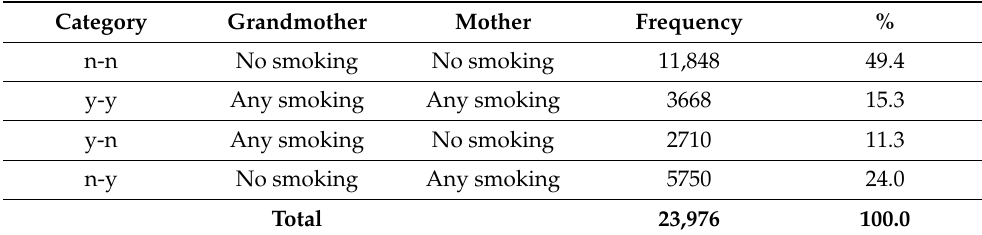
Table 1. Smoking during pregnancy in the included